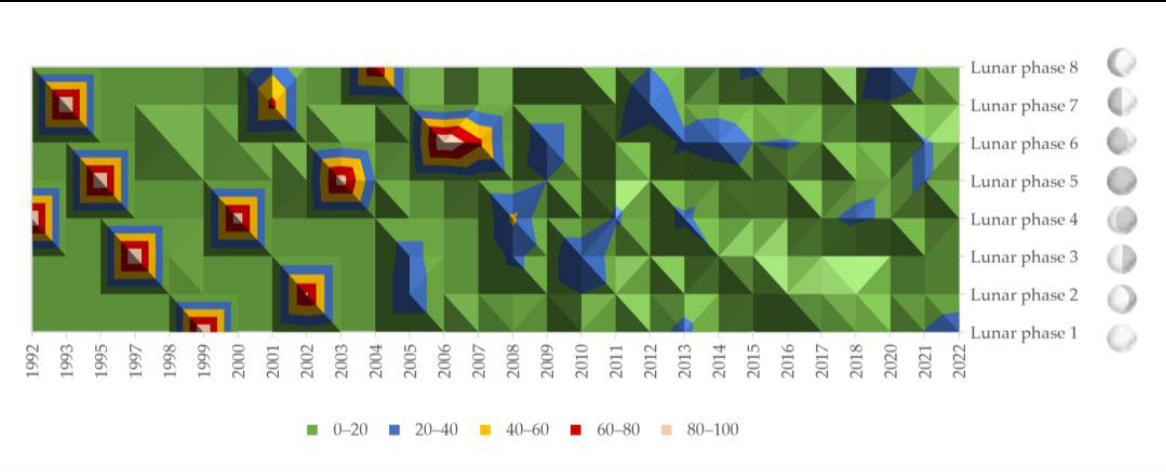
Figure 1. Relative frequency (percentage, %) of spontaneous onset of labor in each lunar phase per year. The relative frequency of spontaneous onset of parturition is defined as the number of births in each lunar phase in relation to all episodes of spontaneous onset of labor recorded in a specific year.